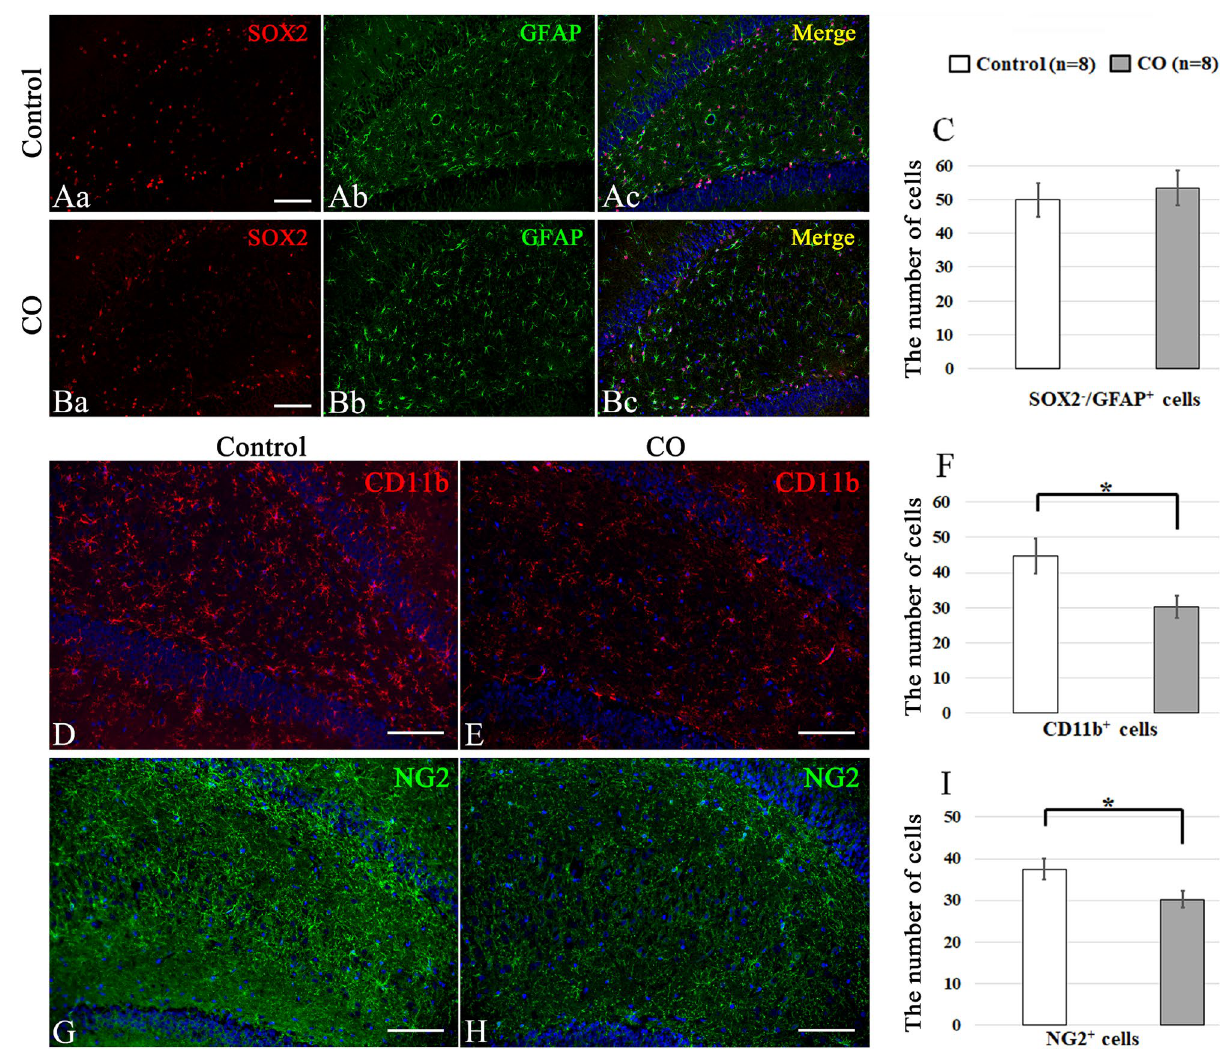
Figure 3. Immunohistochemical analyses of the dentate gyrus 21 days after CO exposure, and the number of SOX2 − /GFAP + , CD11b + , and NG2 + cells in the dentate gyrus. ( A ) Immunohistochemical analyses were performed using antibodies against SOX2 (red) and GFAP (green) for controls ( Aa – c ) at 21 days. ( B ) Immunohistochemical analyses were performed using antibodies against SOX2 (red) and GFAP (green) for the CO rats ( Ba – c ) at 21 days after CO exposure. ( C ) The number of SOX2 − /GFAP + cells is not significantly different between CO rats and controls. ( D ) Immunohistochemical analyses were performed using antibodies against CD11b (red) for controls at 21 days. ( E ) Immunohistochemical analyses were performed using antibodies against CD11b (red) for the CO rats at 21 days after CO exposure. ( F ) The number of CD11b + cells is significantly lower in the CO rats 21 days after CO exposure than in the controls. ( G ) Immunohistochemical analyses were performed using antibodies against NG2 (green) for controls at 21 days. ( H ) Immunohistochemical analyses were performed using antibodies against NG2 (green) for the CO rats at 21 days after CO exposure. Nuclear staining was performed using DAPI solution. ( I ) The number of NG2 + cells is significantly lower in the CO rats 21 days after CO exposure than in the controls. Scale bars = 100 µm ( Aa – c , Ba – c , D , E , G , H ). Values are expressed as mean ± SEM. * p <